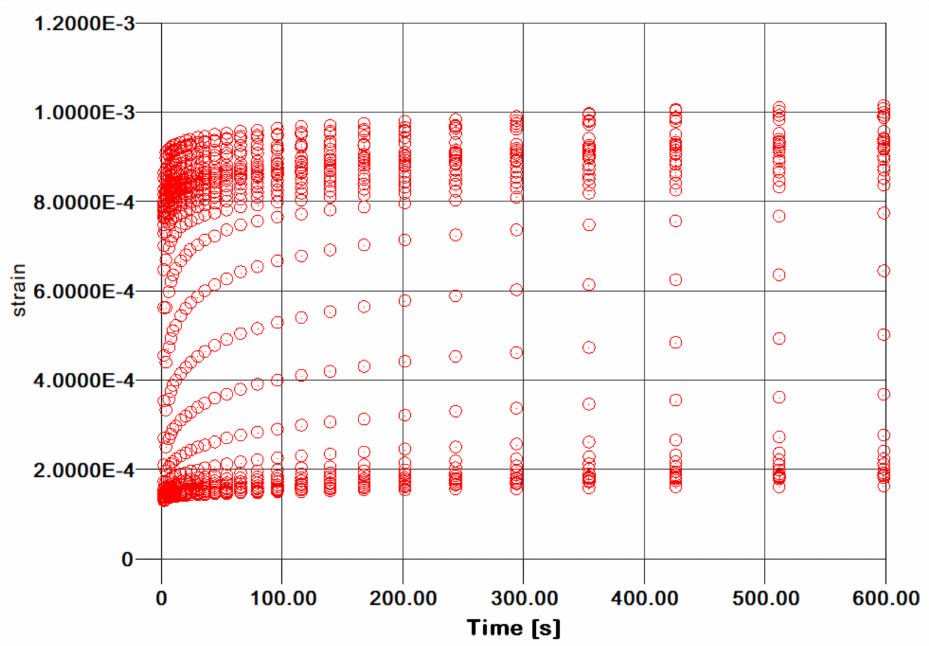
Figure 4. Kevlar/Aluminum–glass composite hybrid creep time–temperature superposition TTS curves.